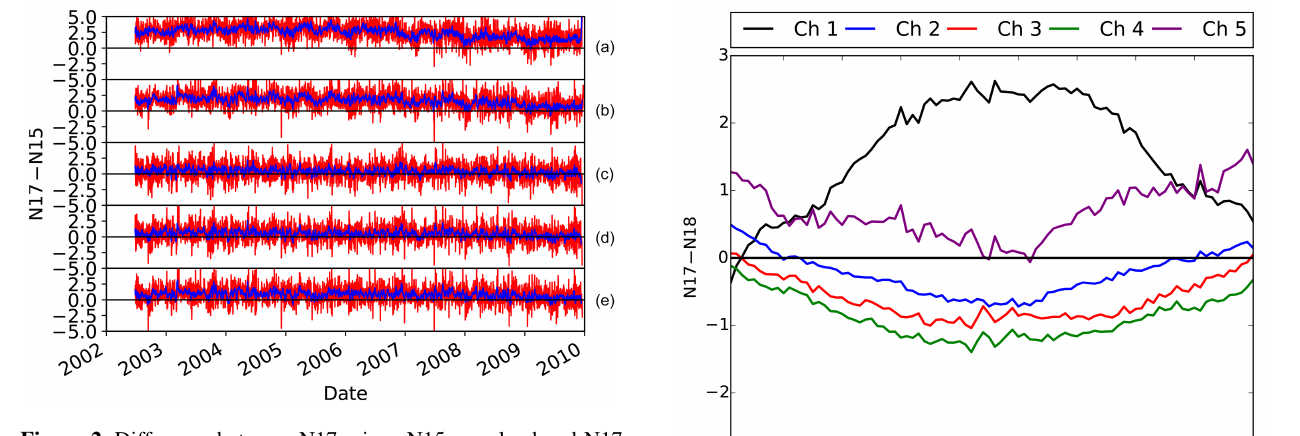
Figure 2. Difference between N17 minus N15 over land and N17 minus N15 over ocean in the tropical region. The blue lines show the weekly-moving averages. (a) – (e) are channels 1–5.